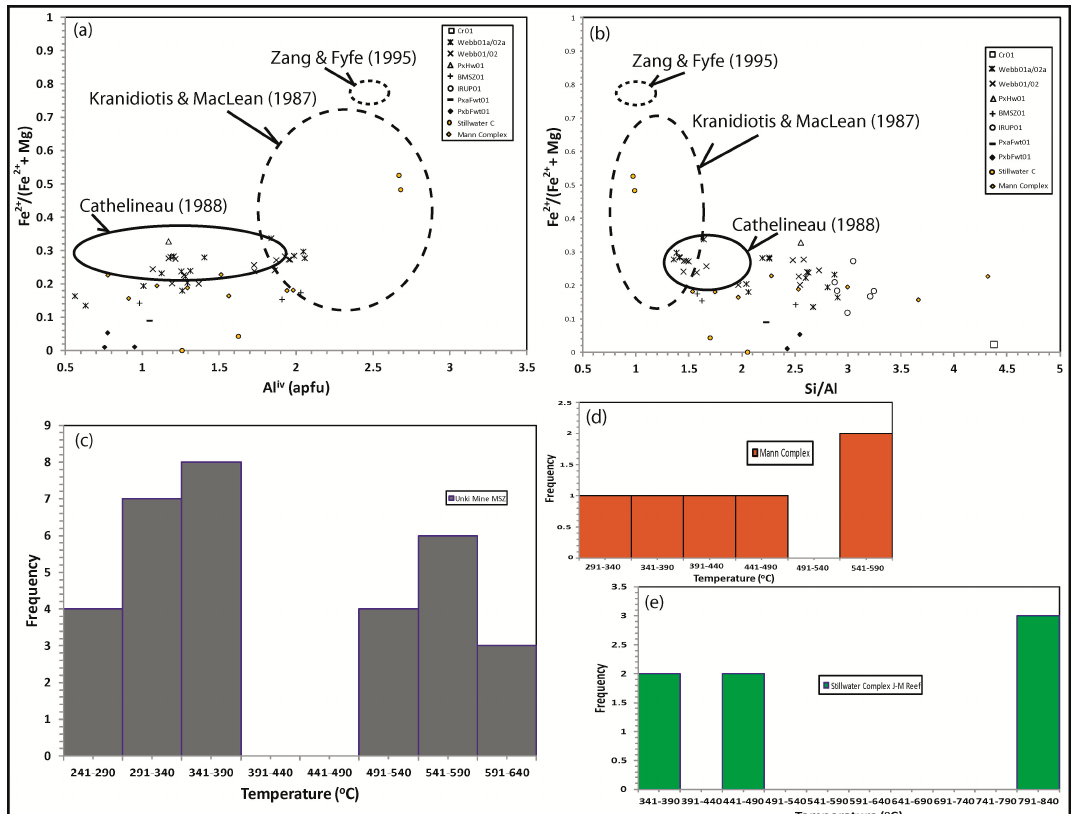
Figure 19. Plot of chlorite Fe/(Fe + Mg) versus Al iv (atoms per formula unit—apfu) ( a ) and chlorite Fe/(Fe + Mg) versus Si/Al ( b ) compared with those obtained from empirical temperature estimates of Kranidiotis and MacLean (1987) [61], Cathelineau (1988) [62], and Zang and Fyfe (1995) [63]. Compositional fields of chlorites from the Stillwater Complex and Mann Complex are plotted for comparison. Chlorites from the MSZ at Unki Mine are generally consistent with those from Cathelineau (1988) [62], and to a limited degree with those from Kranidiotis and MacLean (1987) [61]. A histogram of crystallization temperatures of chlorites from the MSZ at Unki Mine calculated by the empirical method of Cathelineau (1988) [62] is shown in ( c ), whereas ( d ) and ( e ) show chlorite crystallization temperatures calculated by the method of Cathelineau (1988) [62] for chlorites from the Mann Complex and Stillwater Complex, respectively.